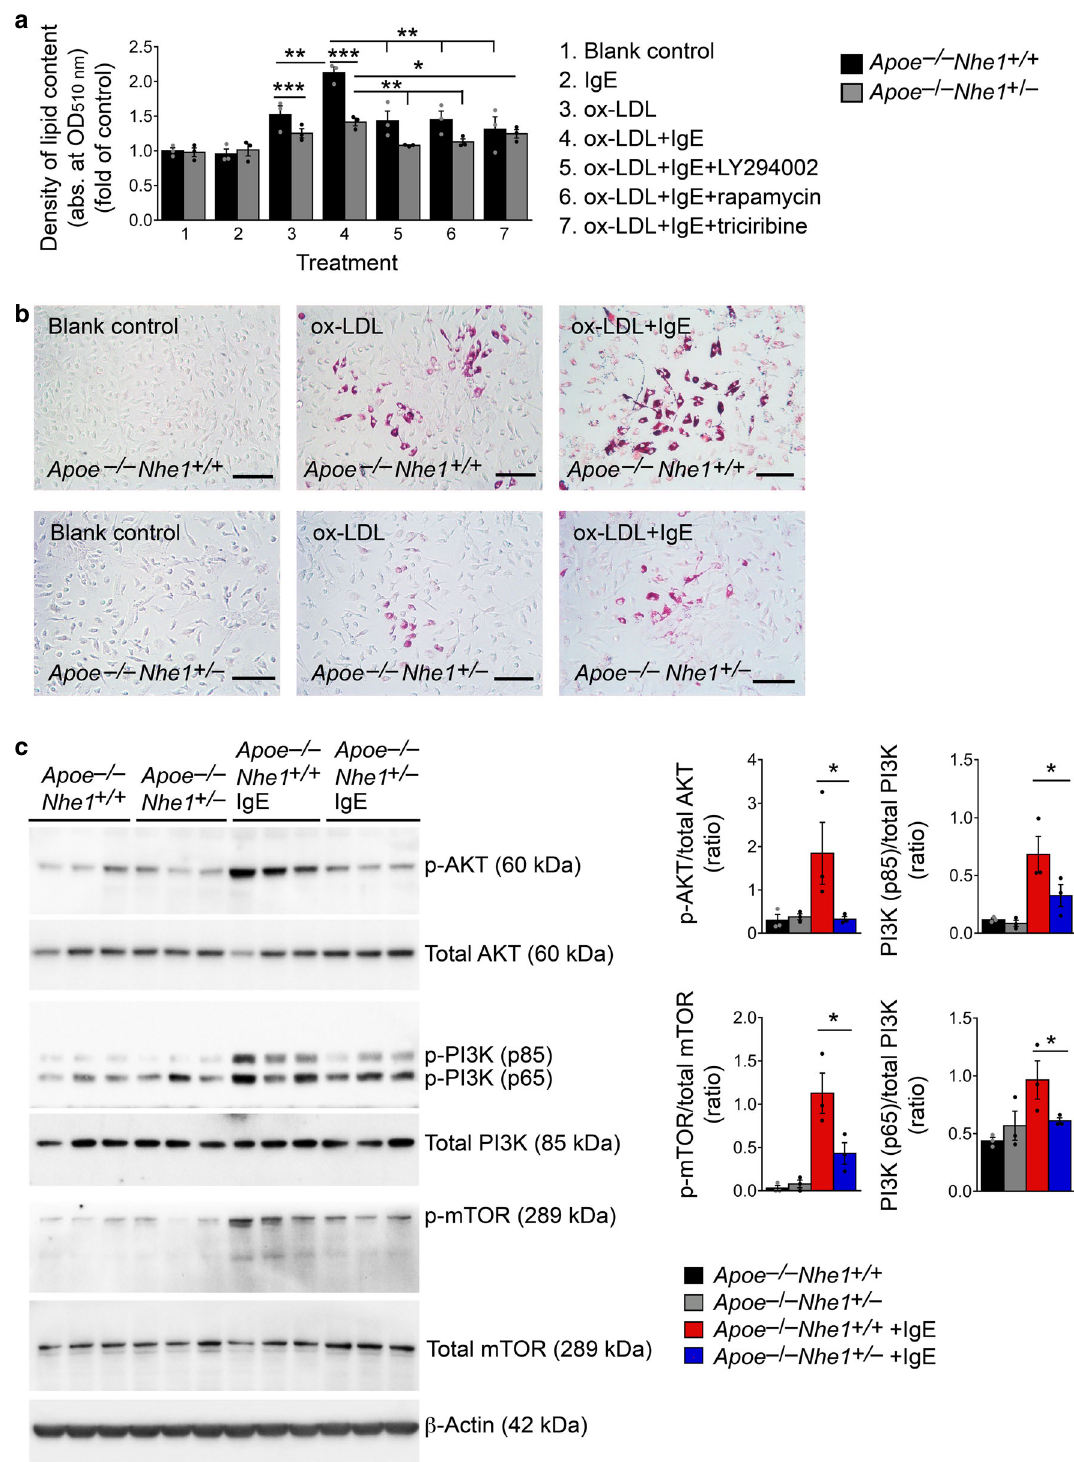
Fig. 5 Role of Nhe1 in IgE-induced macrophage foam cell formation. Intracellular lipid quanti fi cation a and selected representative images b of macrophages from Apoe – / – Nhe1 + / + and Apoe – / – Nhe1 + / – mice after treatment with or without IgE, ox-LDL, PI3 kinase inhibitor LY294002, AKT inhibitor triciribine, and mTOR inhibitor rapamycin as indicated. Bars: 200 µ m. c Immunoblot analysis of (p)-AKT, (p)-PI3K, (p)-mTOR, and β -actin in macrophages from Apoe – / – Nhe1 + / + and Apoe – / – Nhe1 + / – mice after treatment with and without IgE. Gel density quanti fi cations are shown to the right. Data are presented as mean ± SEM from three independent experiments. One-way ANOVA test followed by a post hoc Tukey ’ s test (p-AKT/total AKT in c ) and Kruskal – Wallis test followed by Dunn's procedure (all other panels) were used to compare three or more groups. * P < 0.05; ** P < 0.01; *** P < 0.001. Source data are